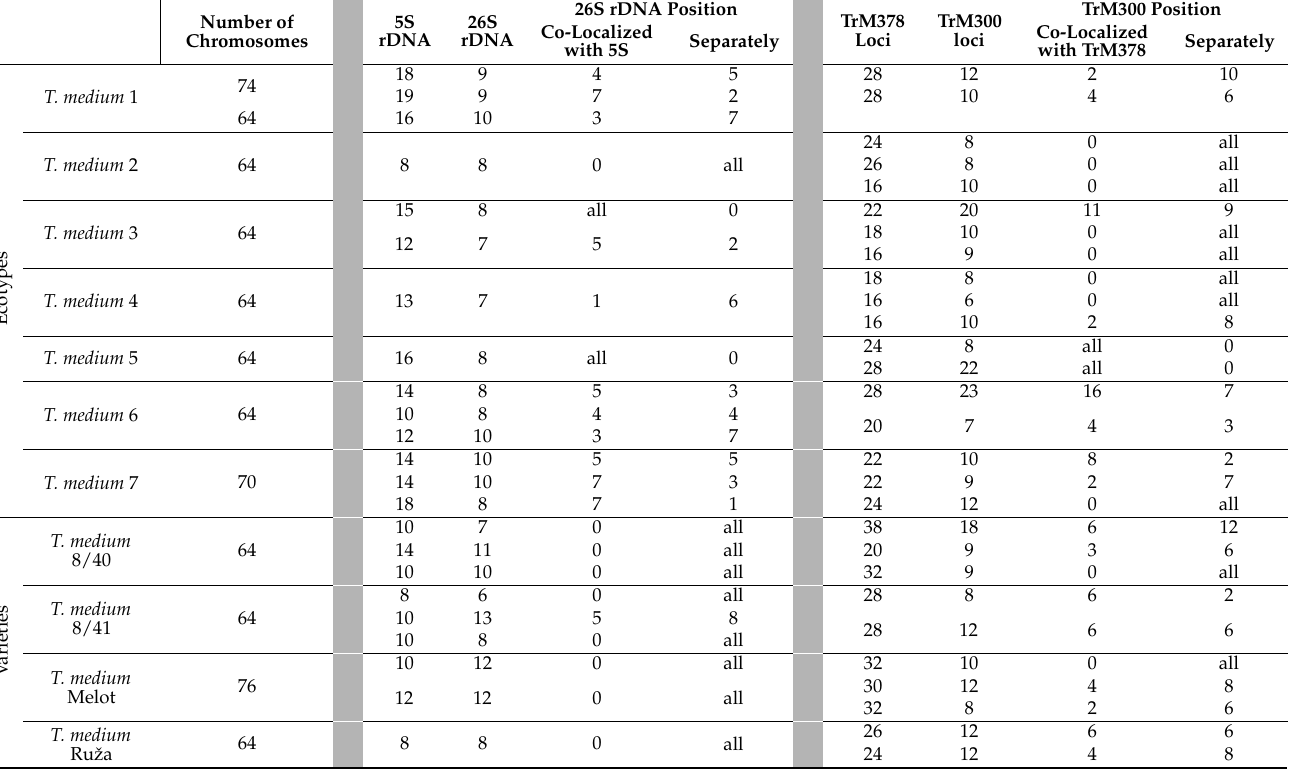
Table 1. Numbers of chromosomes, rDNA loci and centromeric repeats TrM378 and TrM300 loci and their positions in analysed T. medium ecotypes and